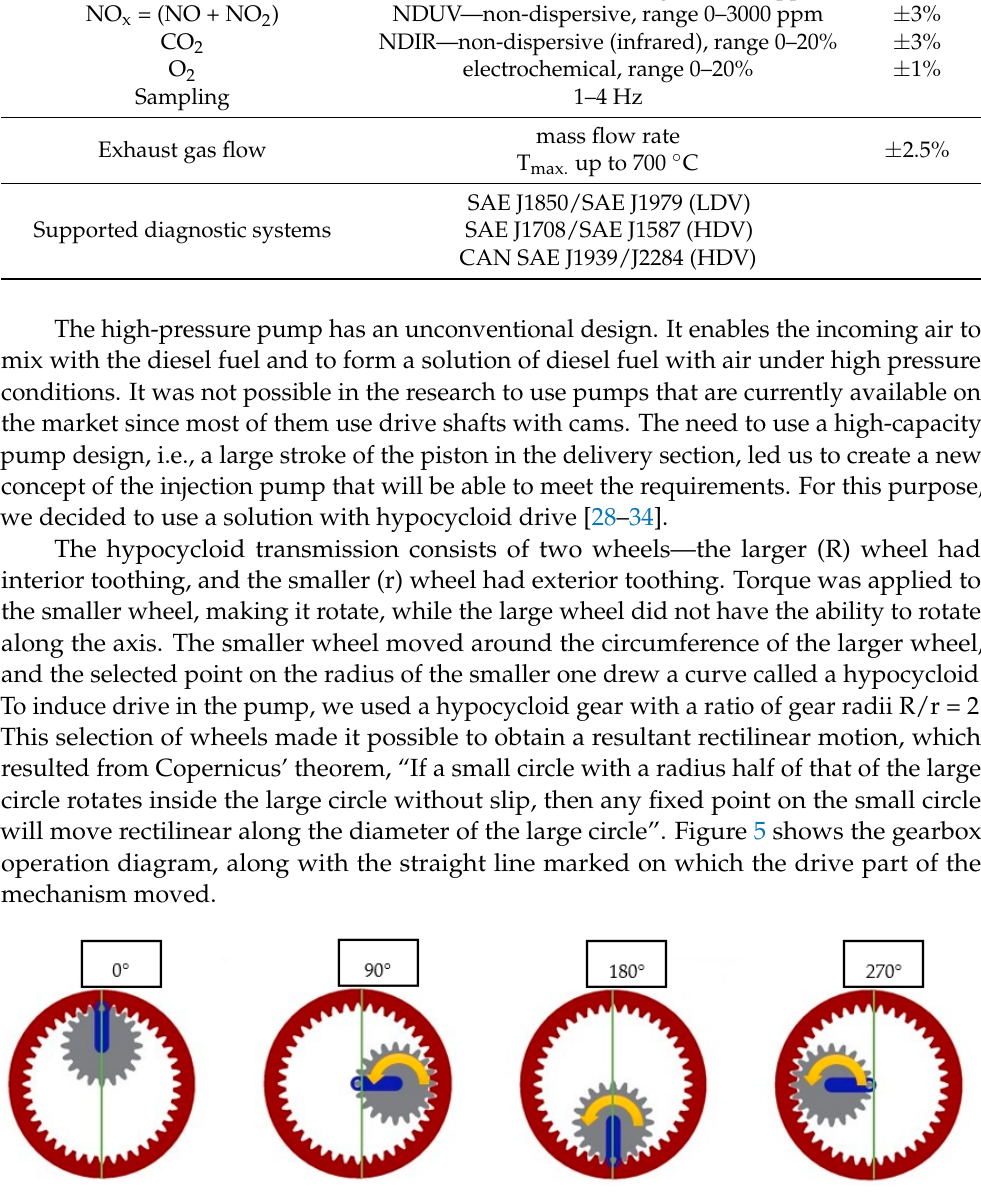
Table 1. Technical data of the Semtech DS.